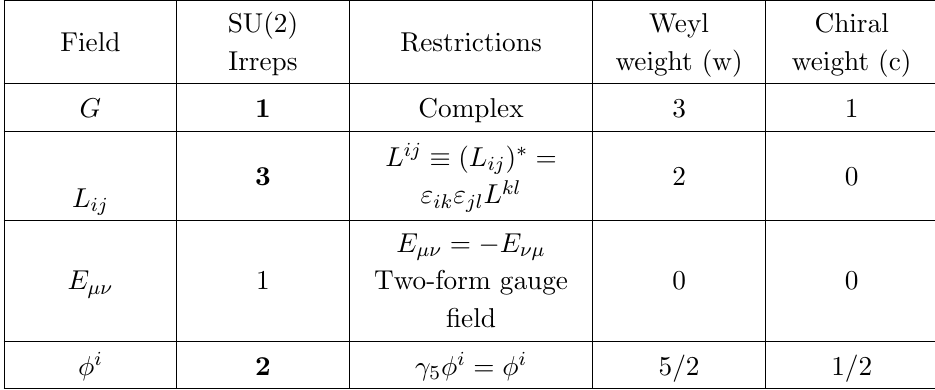
Table 3 . Field content of the N = 2 tensor